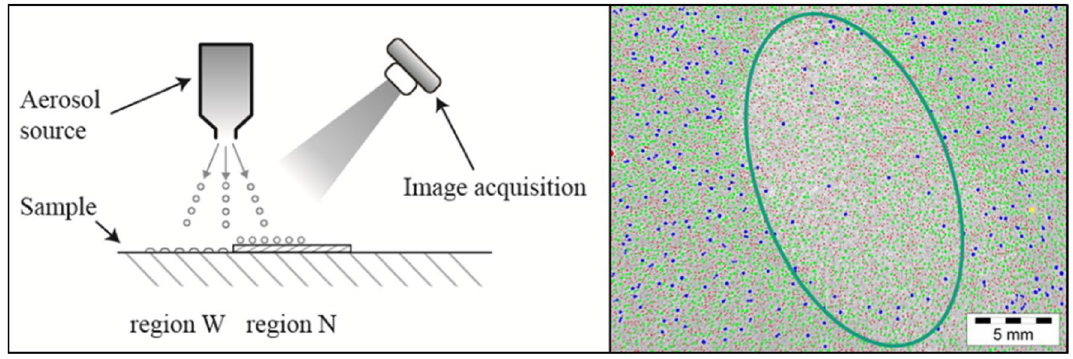
face layers. Right: Post-processed photo-optical image acquired by AWT, revealing contrast in surface wettability resulting from apply- ing greasy fingerprints on a demonstrator